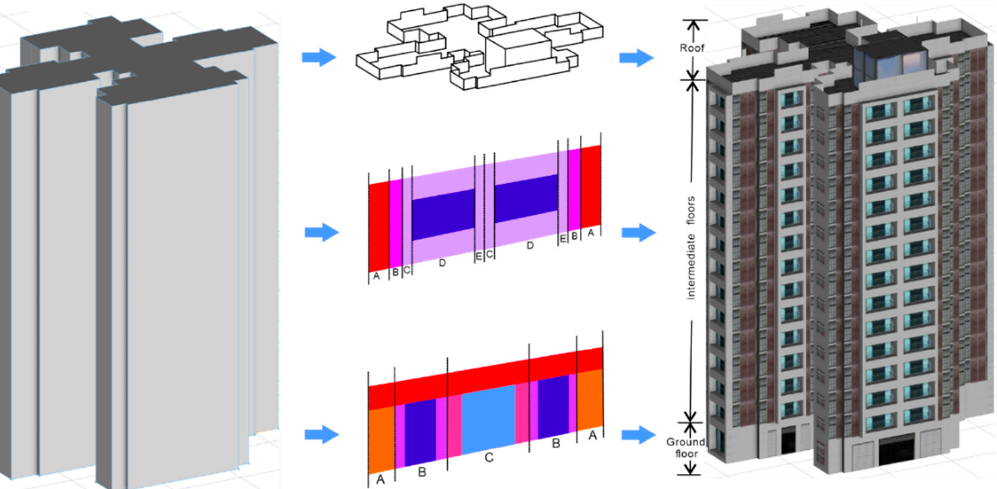
Figure 6. Texture mapping of building, dividing a typical building to ground floor, intermediate floors, and roof from bottom to top; Each part consists of repeating pairs of elements; The detailed facade synthesis is conducted by combing the grammar-based splitting with texture mapping.